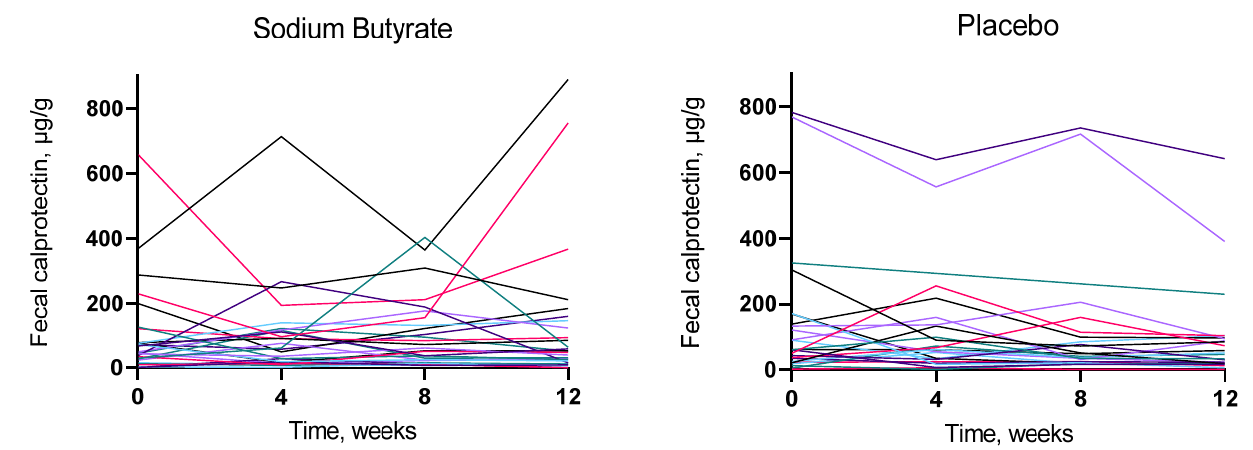
Figure 2. Effects of 12 weeks of treatment with sodium butyrate or placebo on fecal calprotectin. Each colored line represents one participant.